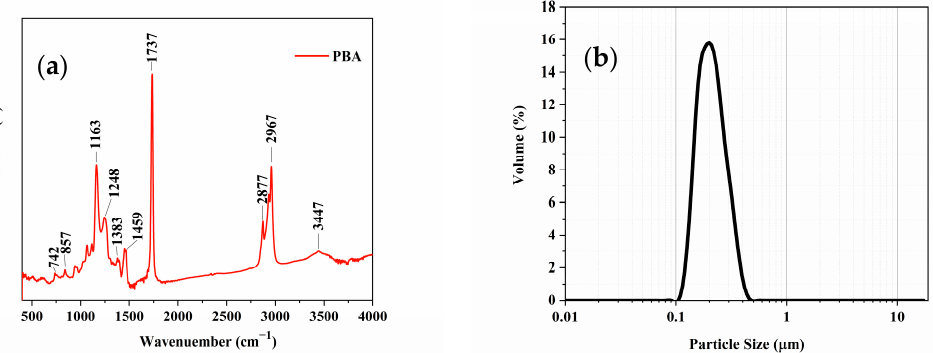
Figure 3. Characterization of polymer emulsion. ( a ) Infrared spectrogram. ( b ) Grain size distribution map.